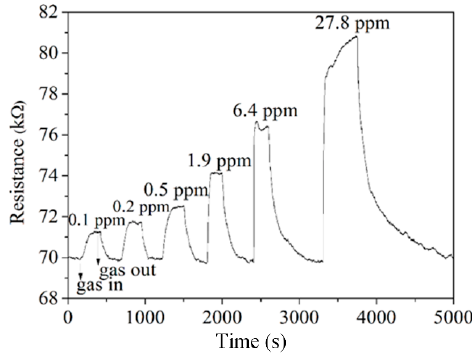
ff erent concentrations of ammonia. Micromachines 2020 , 11 , x